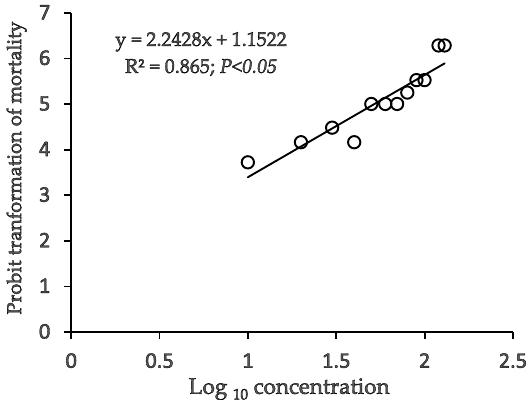
Figure 2. The 96 h Pb(NO 3 ) 2 LC 50 regression curve for O. niloticus. Table 2. The 96 h LC 50 values for different formulations of Pb in the Oreochromis genus. Value of 96-h LC 50 Formulation of Species (mg L − 1 ) Toxicant